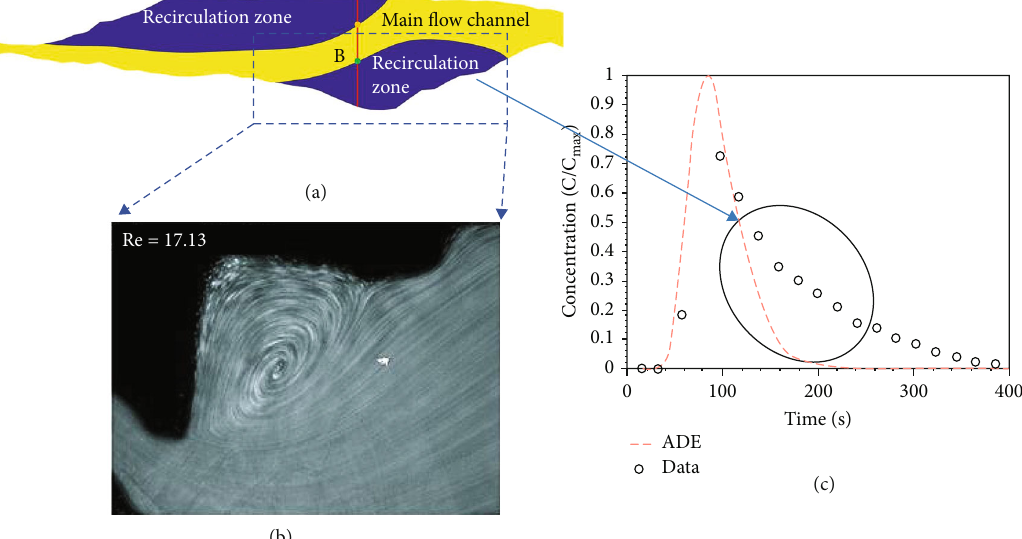
Figure 1: Schematic of the tailing behavior caused by roughness of single fractures. (a) A partition chart for the fl ow in the single fracture [12]. (b) A microscopic picture of particle fl ow in the fracture [13]. (c) A breakthrough curved in which the tailing behavior can be noticed and ADE fails to capture the transport